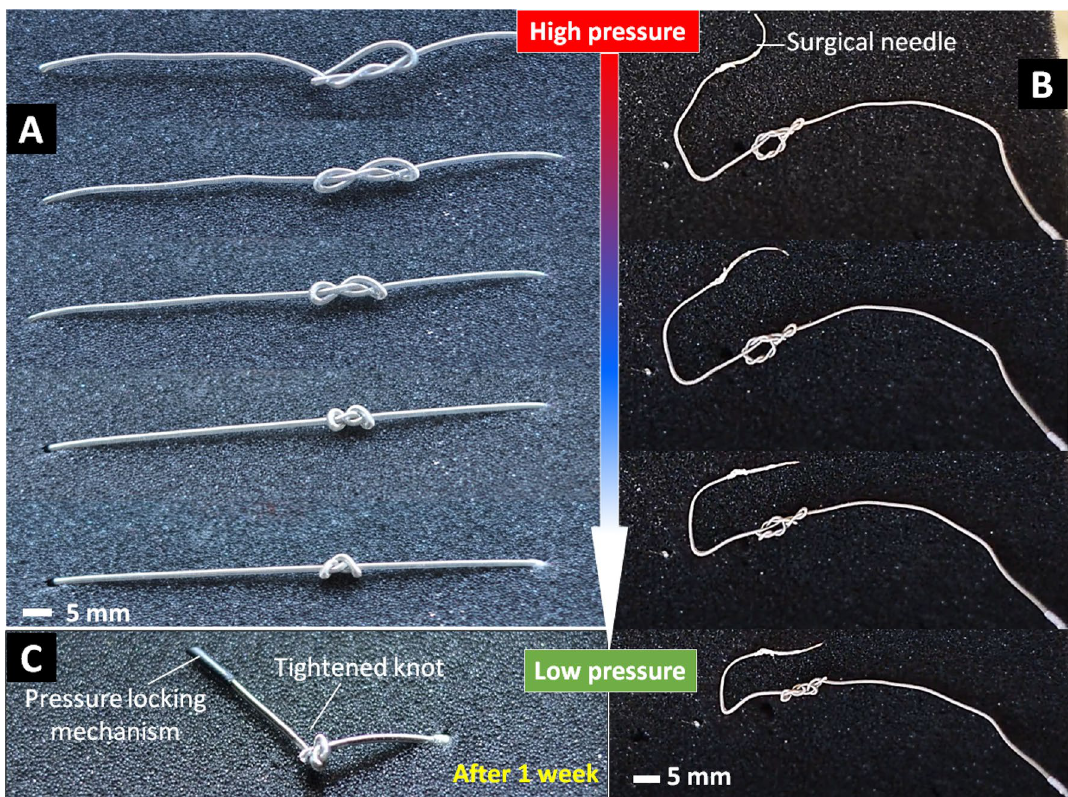
Figure 6. Self-tightening capability and knot security of the S 2 suture-knot. ( A ) A prototype (OD1.49 ×